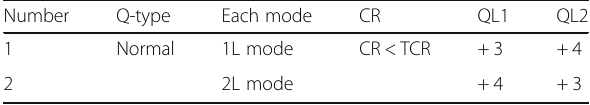
Table 3 Adjustment in RLP process for 1L/2L BRC algorithm